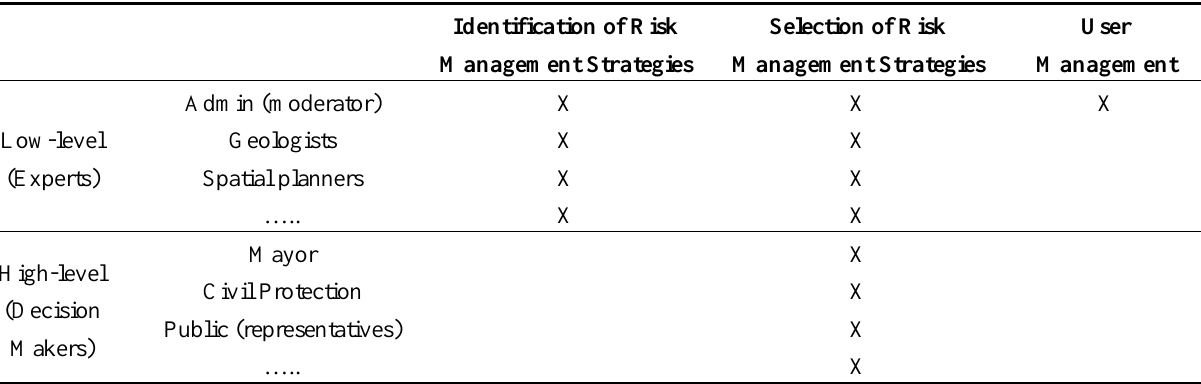
Table 1. The potential end-users (stakeholders) and their different access rights to the main modules of the online participative